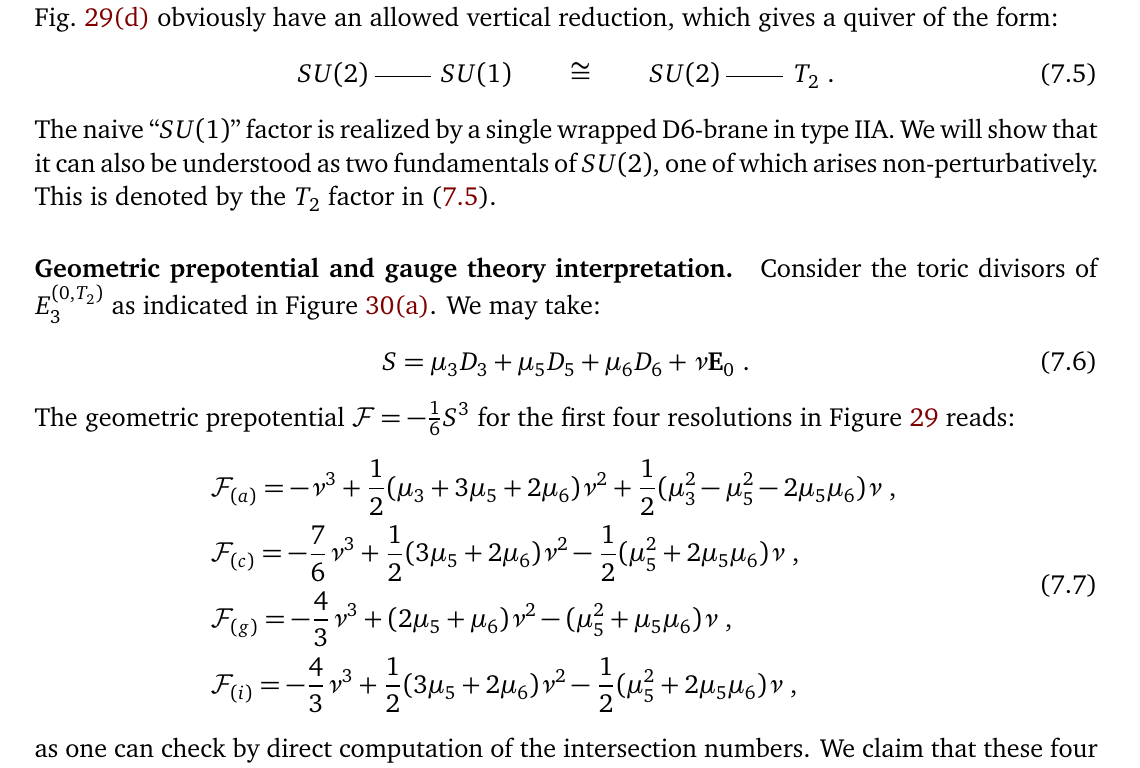
Figure 29: The 5 triangulations of the E we indicated the SU ( 2 ) N explain in the